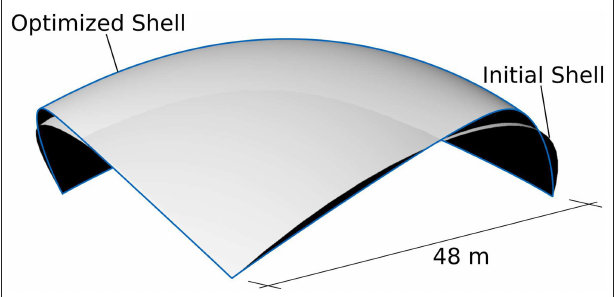
FIGURE 8 | Spherical shape of Kresge Auditorium (initial shell) and numerically generated hanging model (optimized